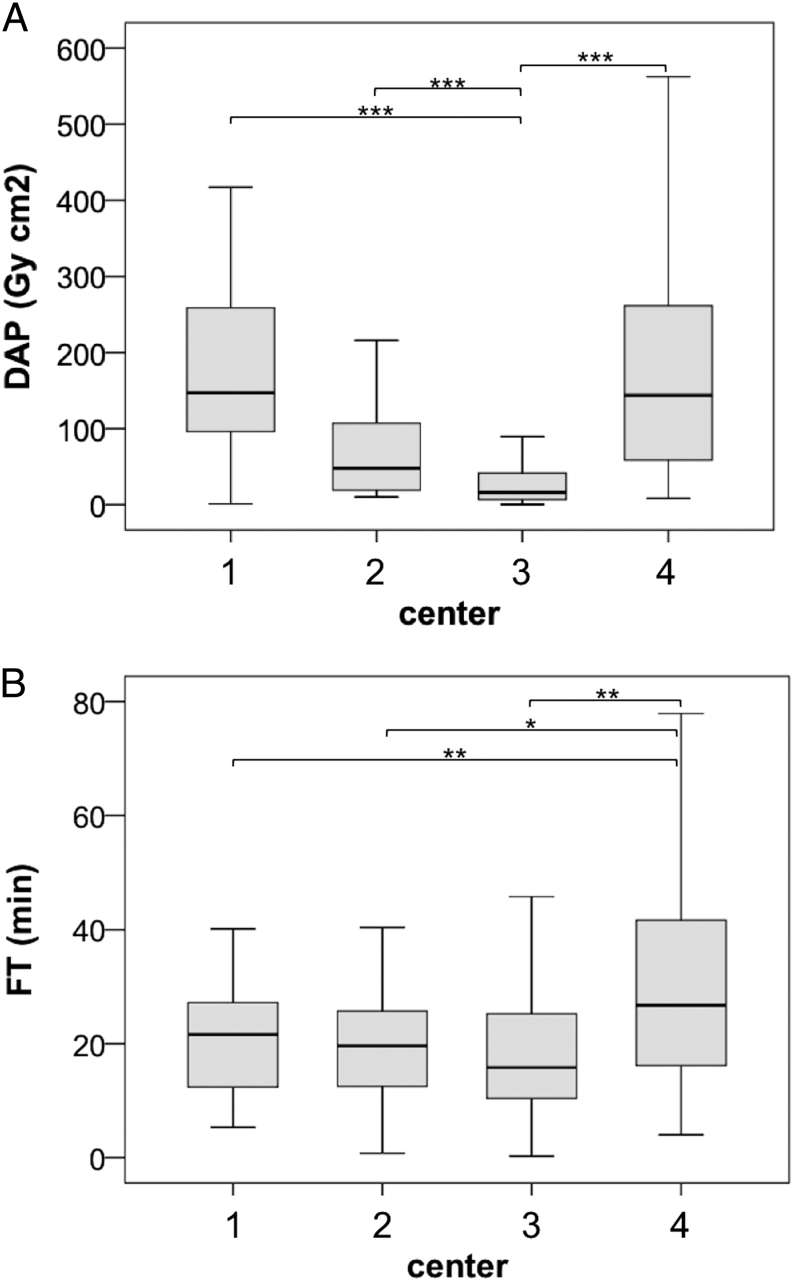
Dose area product (DAP, Gy*cm2) and fluoroscopy time (FT, min) in participating centers. (A) DAP, 1 vs 3 P < 0.001, 2 vs 3 P < 0.001, 3 vs 4 P < 0.001, (B) FT, 1 vs 4 P = 0.001, 2 vs 4 P = 0.002, 3 vs 4 P < 0.001. *P ≤ 0.05, **P ≤ 0.01, ***P ≤ 0.001.